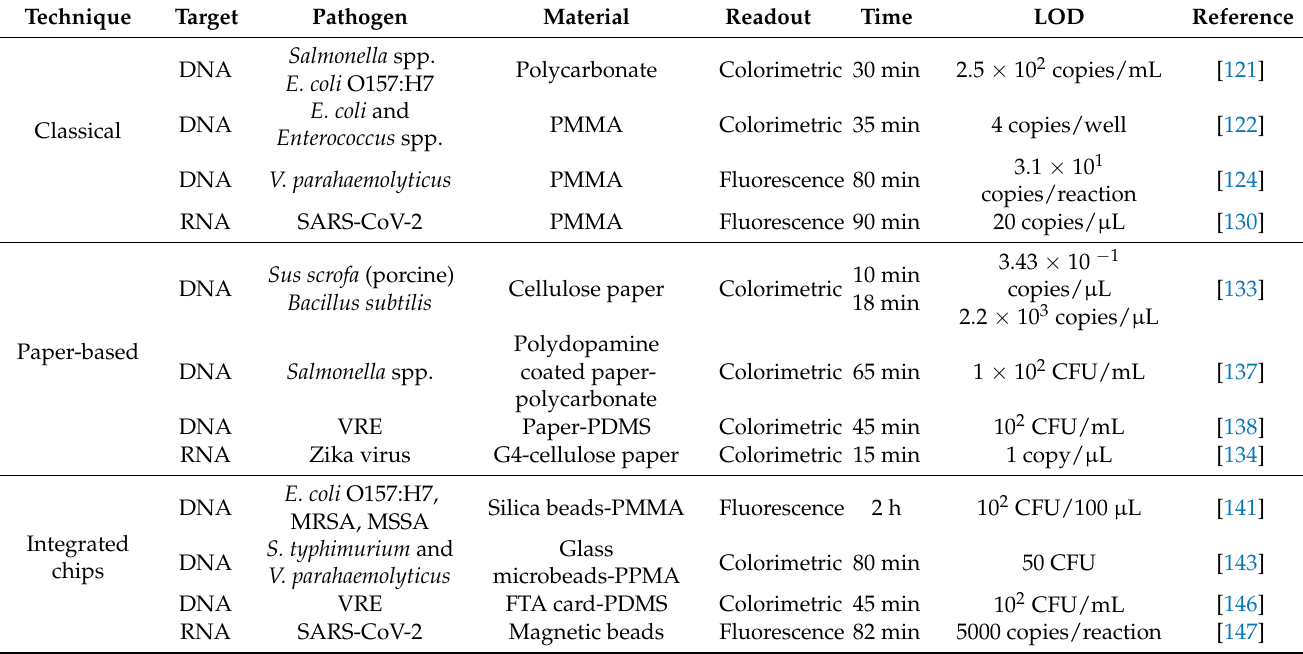
Table 3. Summary of LAMP-based microfluidic